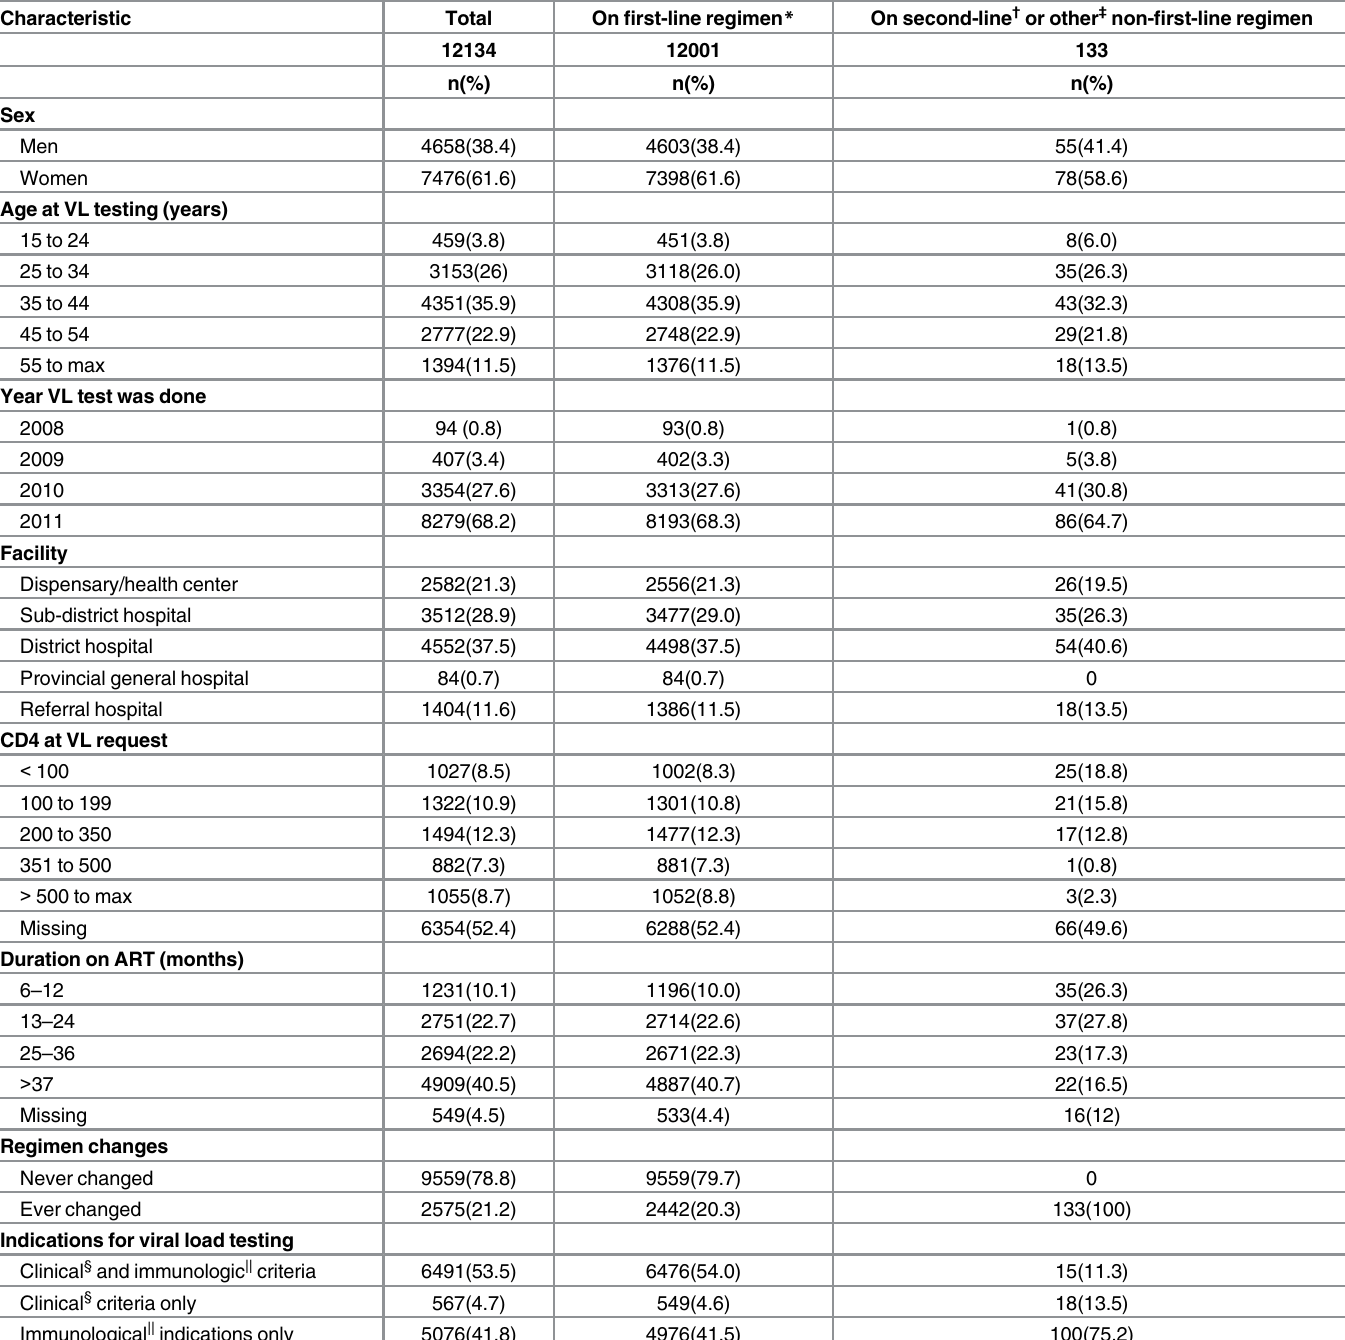
Table 2. Characteristics of adults who underwent targeted viral load testing, Nyanza, Kenya, 2008 – 2011.